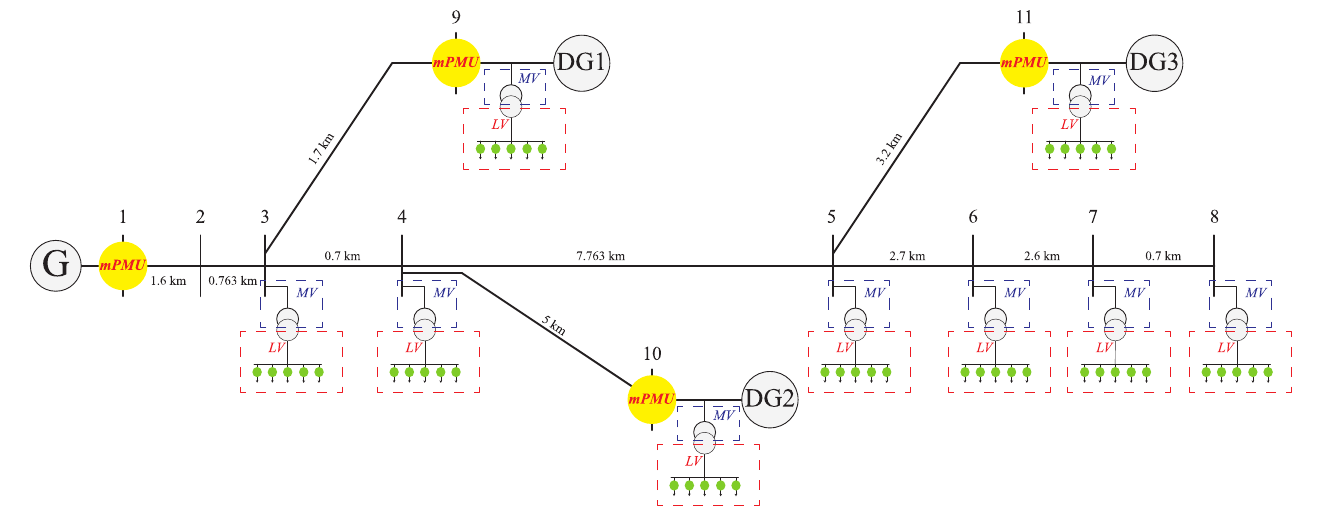
Figure 5. IEEE 11-node test feeder equipped with DGs.